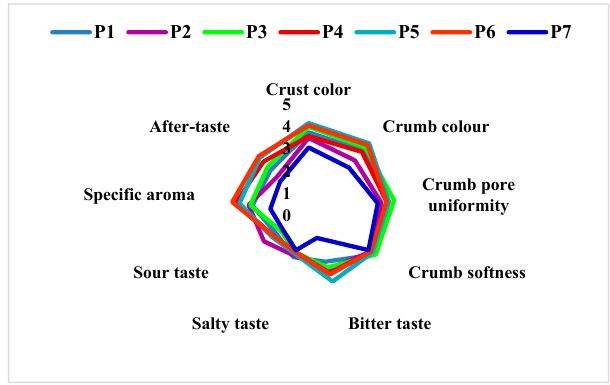
Figure 7. Sensorial properties of bread samples. P1 = 70% wheat + 30% sorghum without L. plantarum ; P2 = 70% wheat + 30% sorghum with L. plantarum ; P3 = 65% wheat + 35% sorghum without L. plantarum ; P4 = 65% wheat + 35% sorghum with L. plantarum ; P5 = 65% wheat + 35% sorghum without L. plantarum ; P6 = 65% wheat + 35% sorghum with L. plantarum ; P7 = 100% wheat flour (type 550).